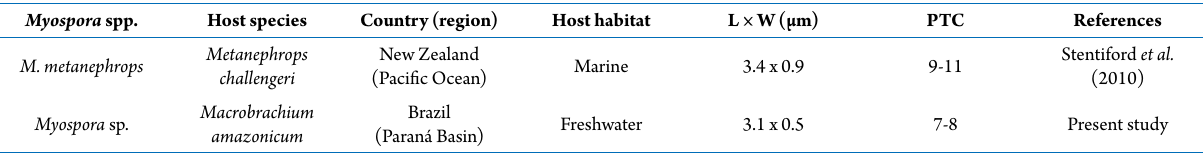
Table 2. Comparison of the spore characteristics of Myospora species. Myospora spp. Host species Country (region) M.